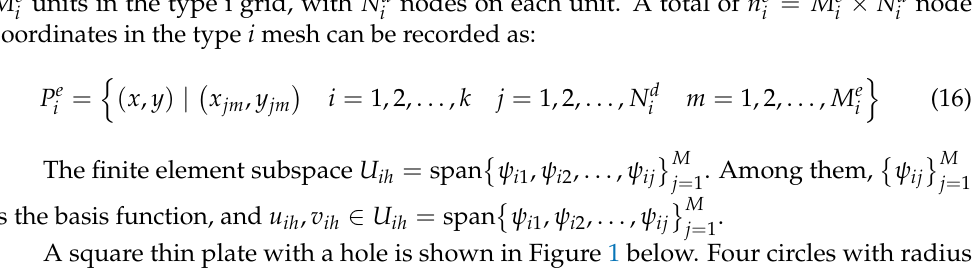
如下图 Fig.1 一个带孔的正方形薄板 , 四个半径为 R 的圆以及椭圆周围被小矩形包裹 . 4  , 1 个包裹椭圆的小矩形记为 个包裹小圆的正方形区域记为 1